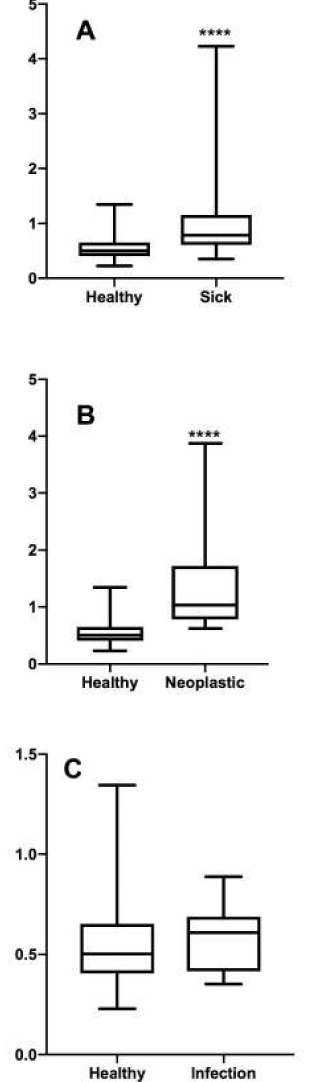
Figure 1. Results of the Mann–Whitney test between ( A ) the ratio of the mean height of right and left medial iliac lymph nodes and the aortic diameter of healthy and sick patients, ( B ) the ratio of the mean height of right and left medial iliac lymph nodes and the aortic diameter of healthy and neoplastic patients, ( C ) the ratio of the mean height of right and left medial iliac lymph nodes and the aortic diameter of healthy and inflammatory patients. **** There are significant di ff erence between two